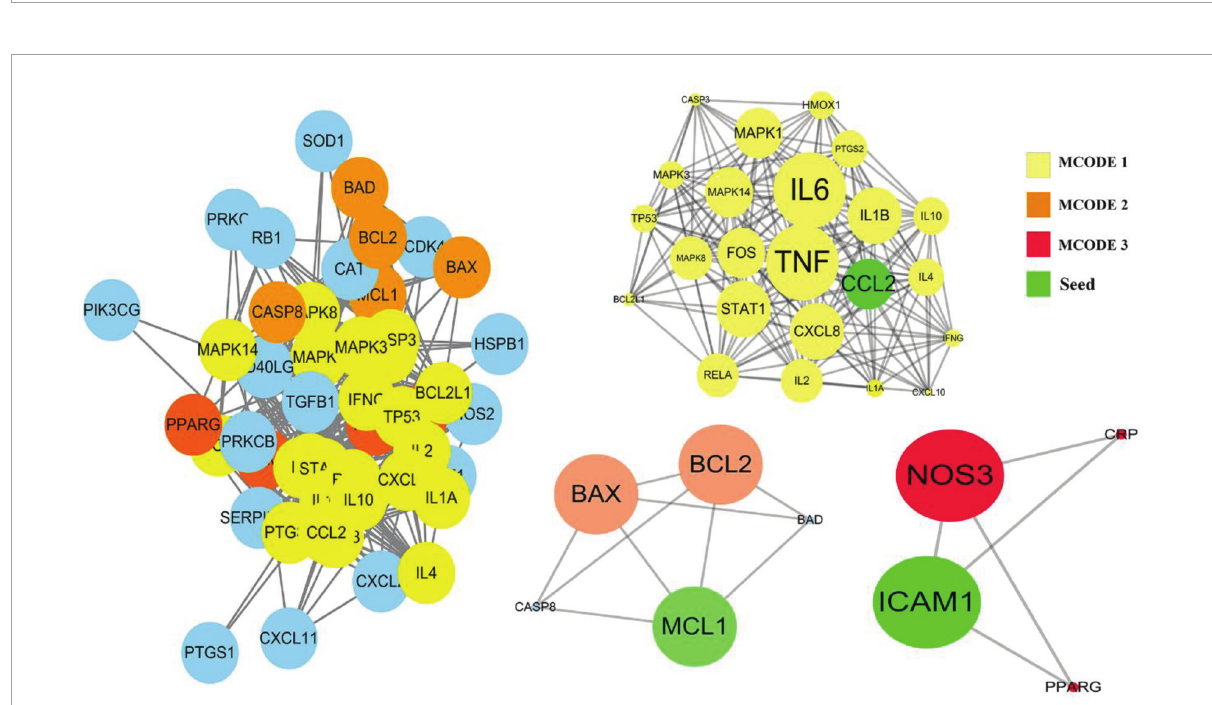
FIGURE4 The hub genes were screened based on